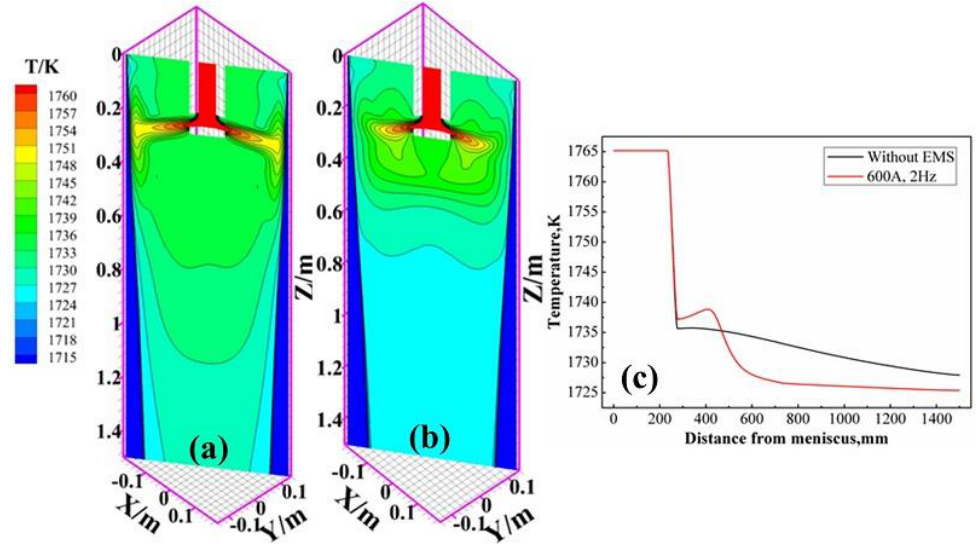
Figure 9. Temperature contour at the diagonal planes (( a ) without EMS; ( b ) 600 A, 2.0 Hz) and molten steel temperature at computational centerline ( c ) for the two cases.